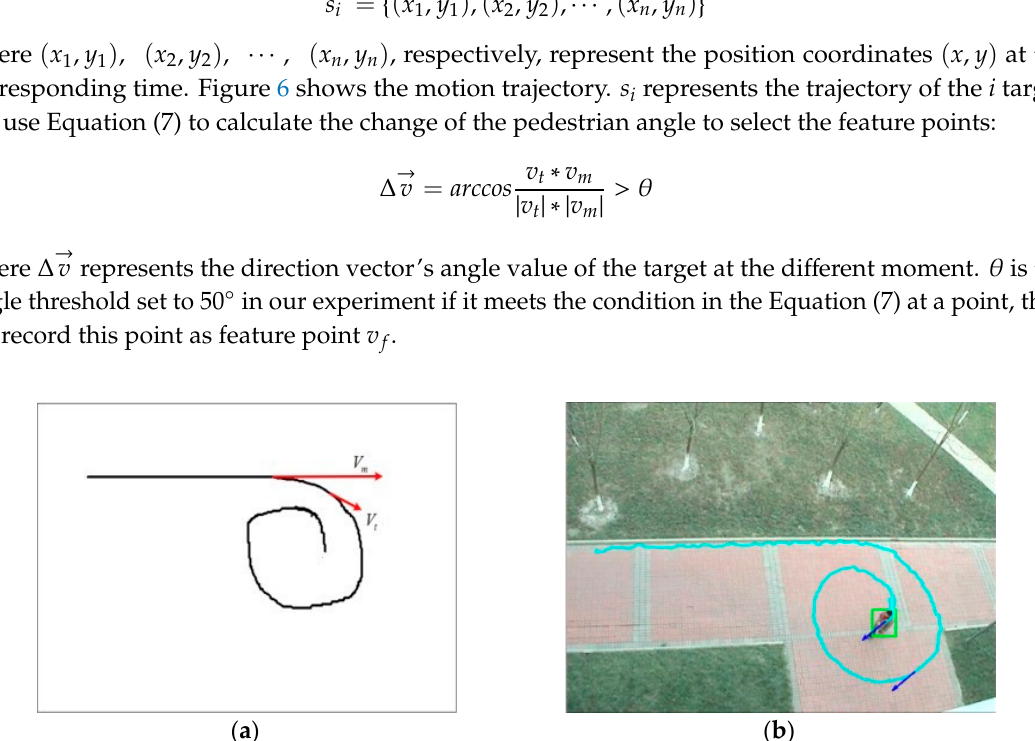
Figure 6. Motion trajectory. ( a )Trajectory models and ( b ) real trajectory.